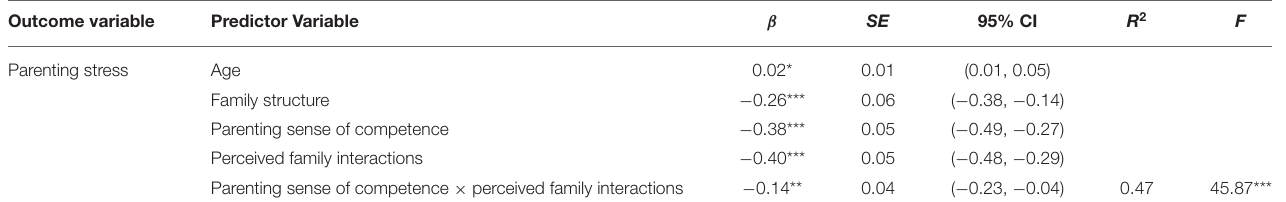
TABLE 2 | Hierarchical regression analysis among study variables.